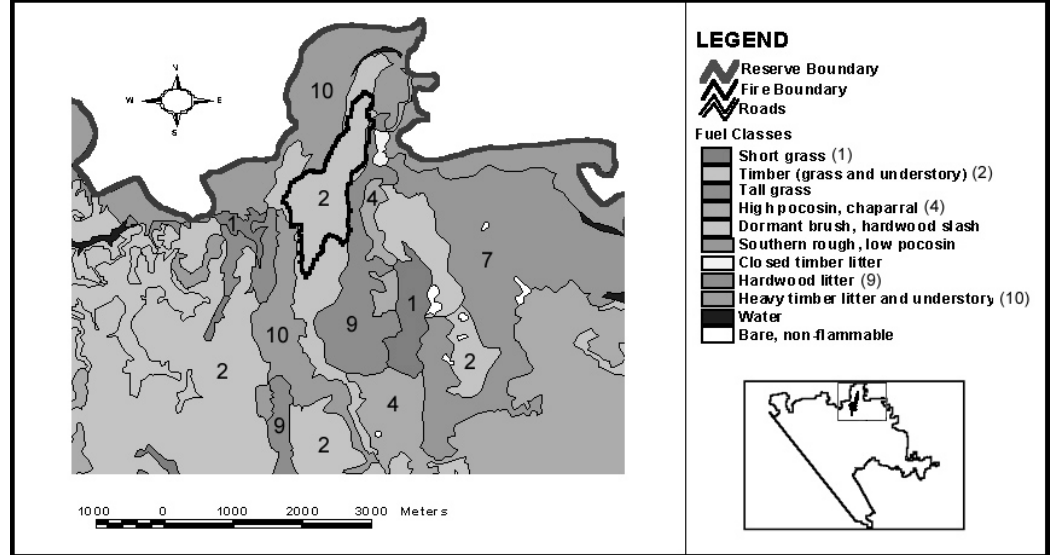
Figure 2. Map of fuel classes for the Mahlala